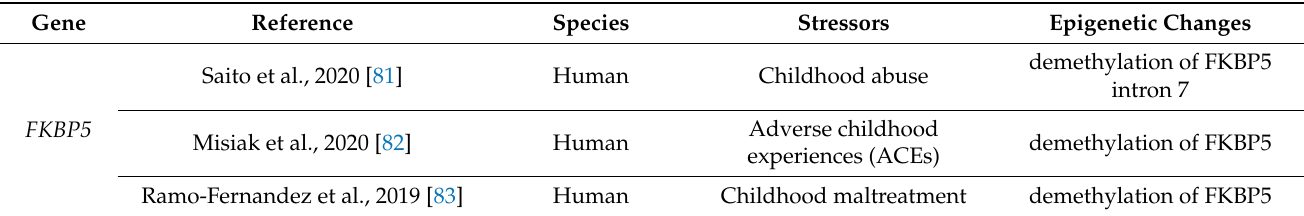
Table 1. Summary of the most recent findings about epigenetic modifications upon stress exposure.